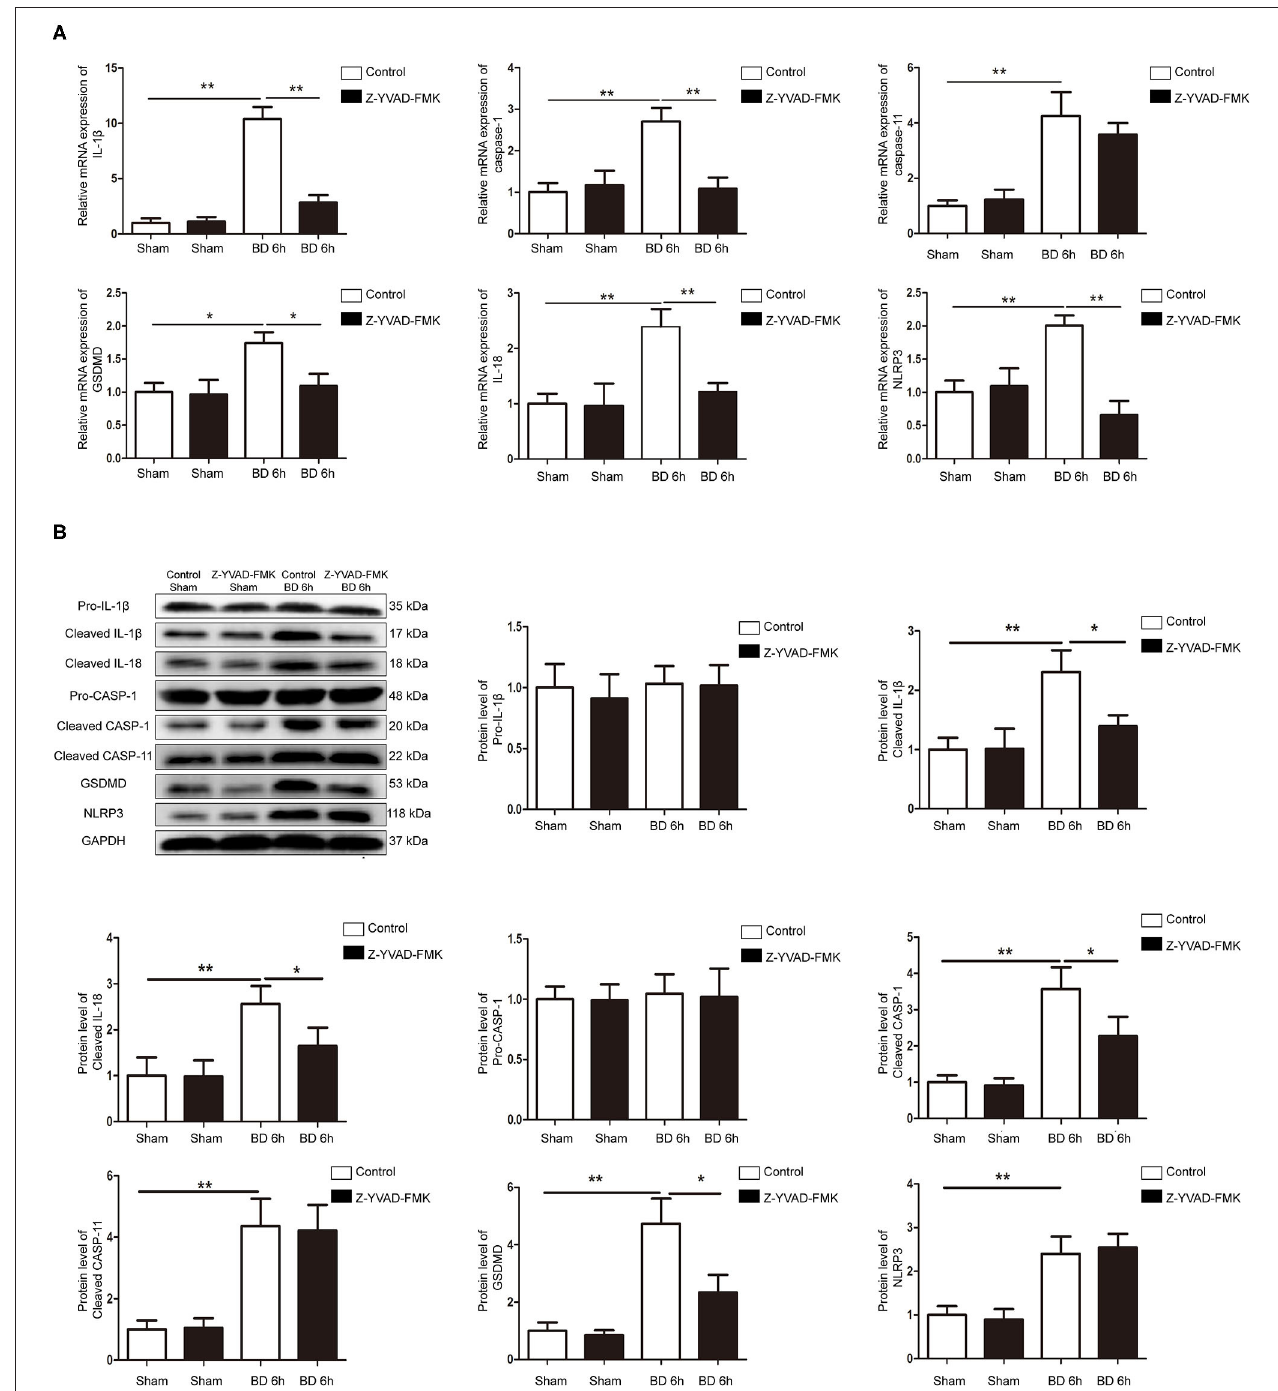
FIGURE 4 | Protein and mRNA expression of pyroptosis-related molecules in control cohort and Z-YVAD-FMK-treated cohort. (A) mRNA expression of NLRP3, caspase-1, caspase-11, GSDMD, IL-1 β , and IL-18 in rat kidney tissuses. (B) Western blotting results of NLRP3, pro-caspase-1, cleaved-caspase-1, cleaved-caspase-11, GSDMD, pro-IL-1 β , cleaved-IL-1 β and cleaved-IL-18. In rat kidney tissues. * p < 0.05, ** p < 0.01. ( n = 6 in each group). BD = brain-death; Sham = without brain death. GSDMD, gasdermin D; GAPDH, glyceraldehyde-3-phosphate dehydrogenase.